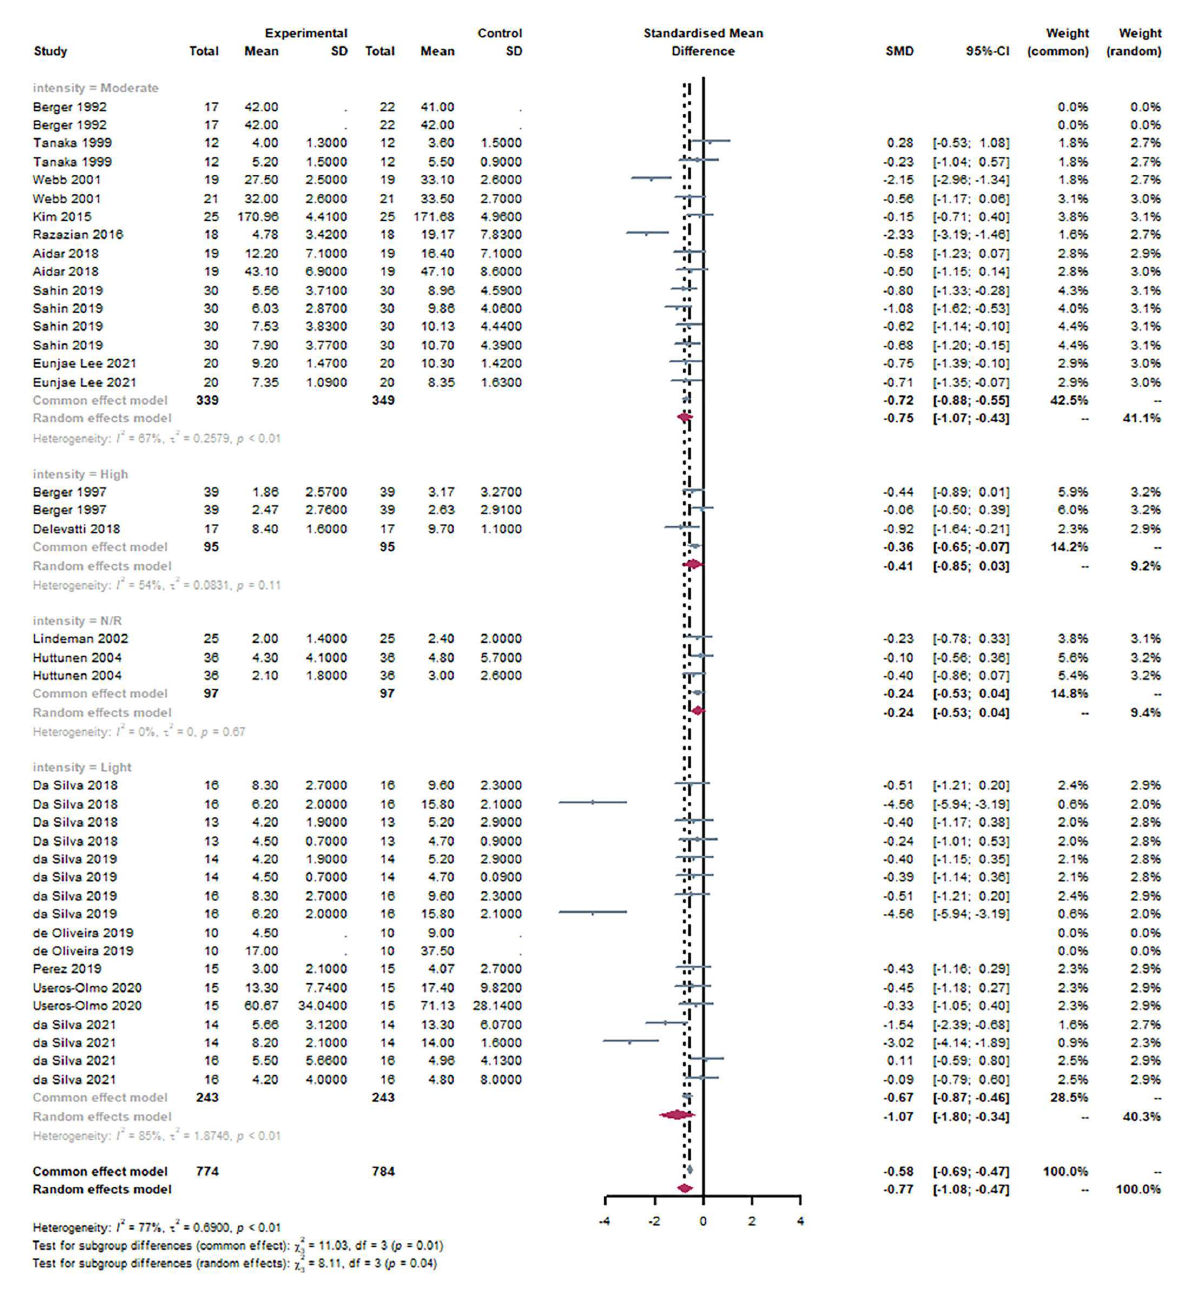
water is more than ten times higher than the resistance of land. Hence, it requires more activation of the motor cortex in the elderly (39). Besides, people with type 2 diabetes are usually not sufficiently active. Activation of the brain and mood improvement are potentially important motivators for